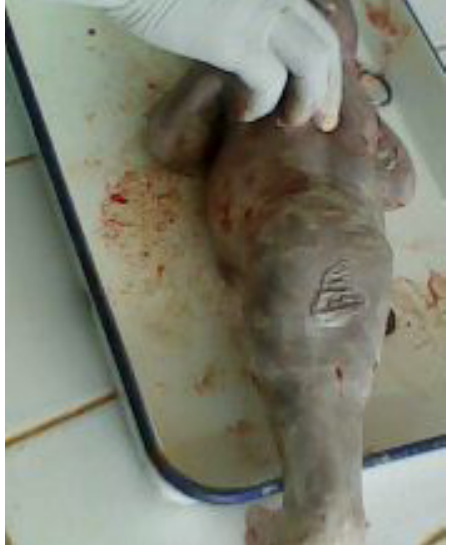
Figure 4. Imperforate anus.